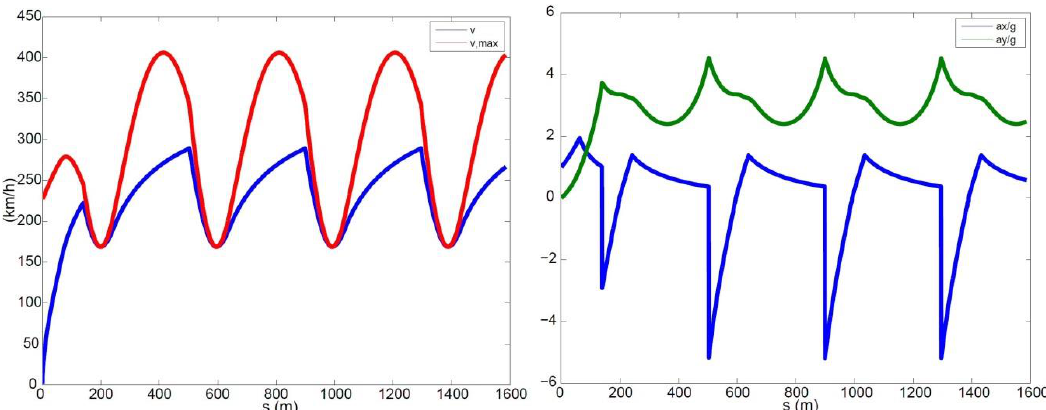
Figure 9. Ellipse, aerodynamics: (left) speed and (right) accelerations with respect to 𝑠 .